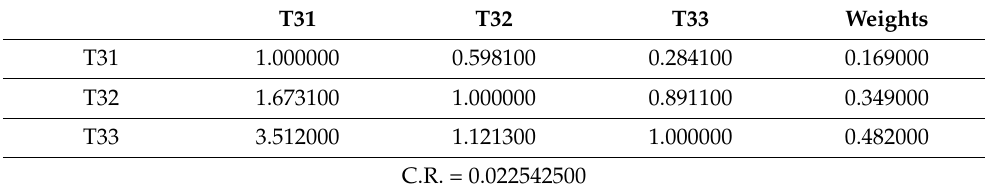
Table 10. Aggregated pair-wise comparison matrix at level 2 for Attack Type.